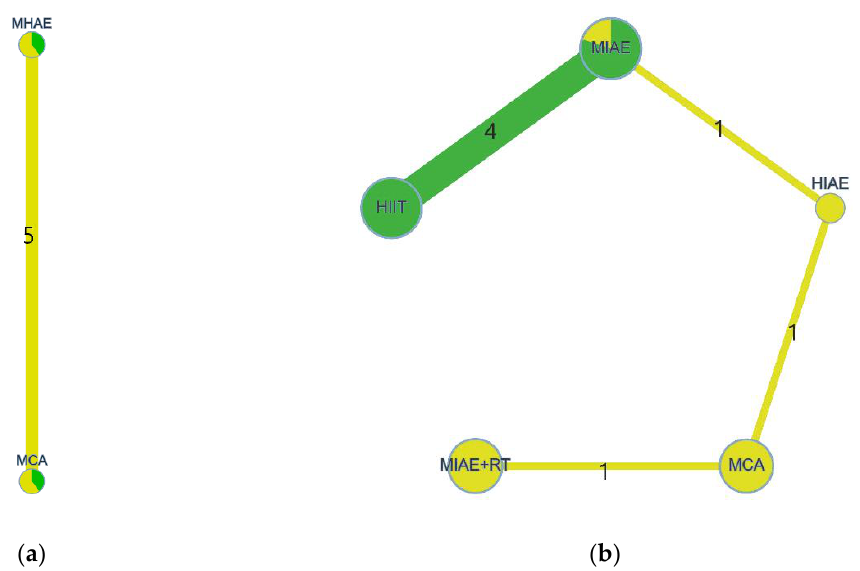
Figure 3. The evidence structure of interventions. ( a ) Healthy participants; ( b ) unhealthy partici- pants.